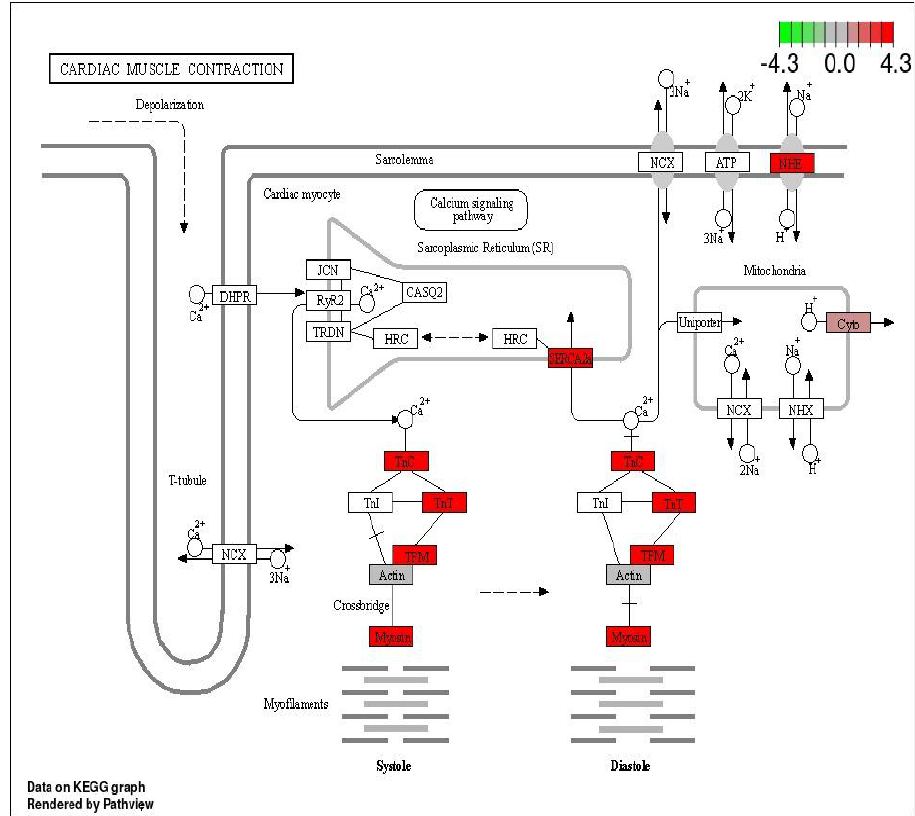
Figure 8. KEGG plot showing the cardiac muscle contraction pathway showing the pathway terms that are enriched in ammonia treatment. The red border shows the enriched terms.